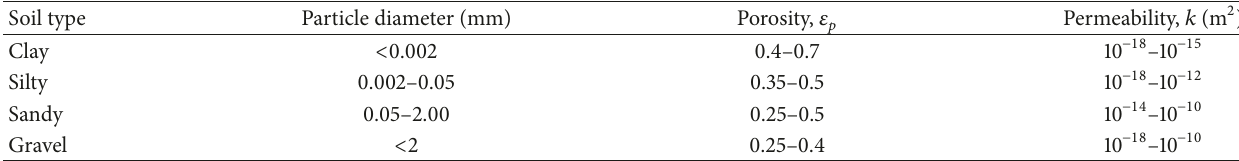
Table 1: Typical soil properties.